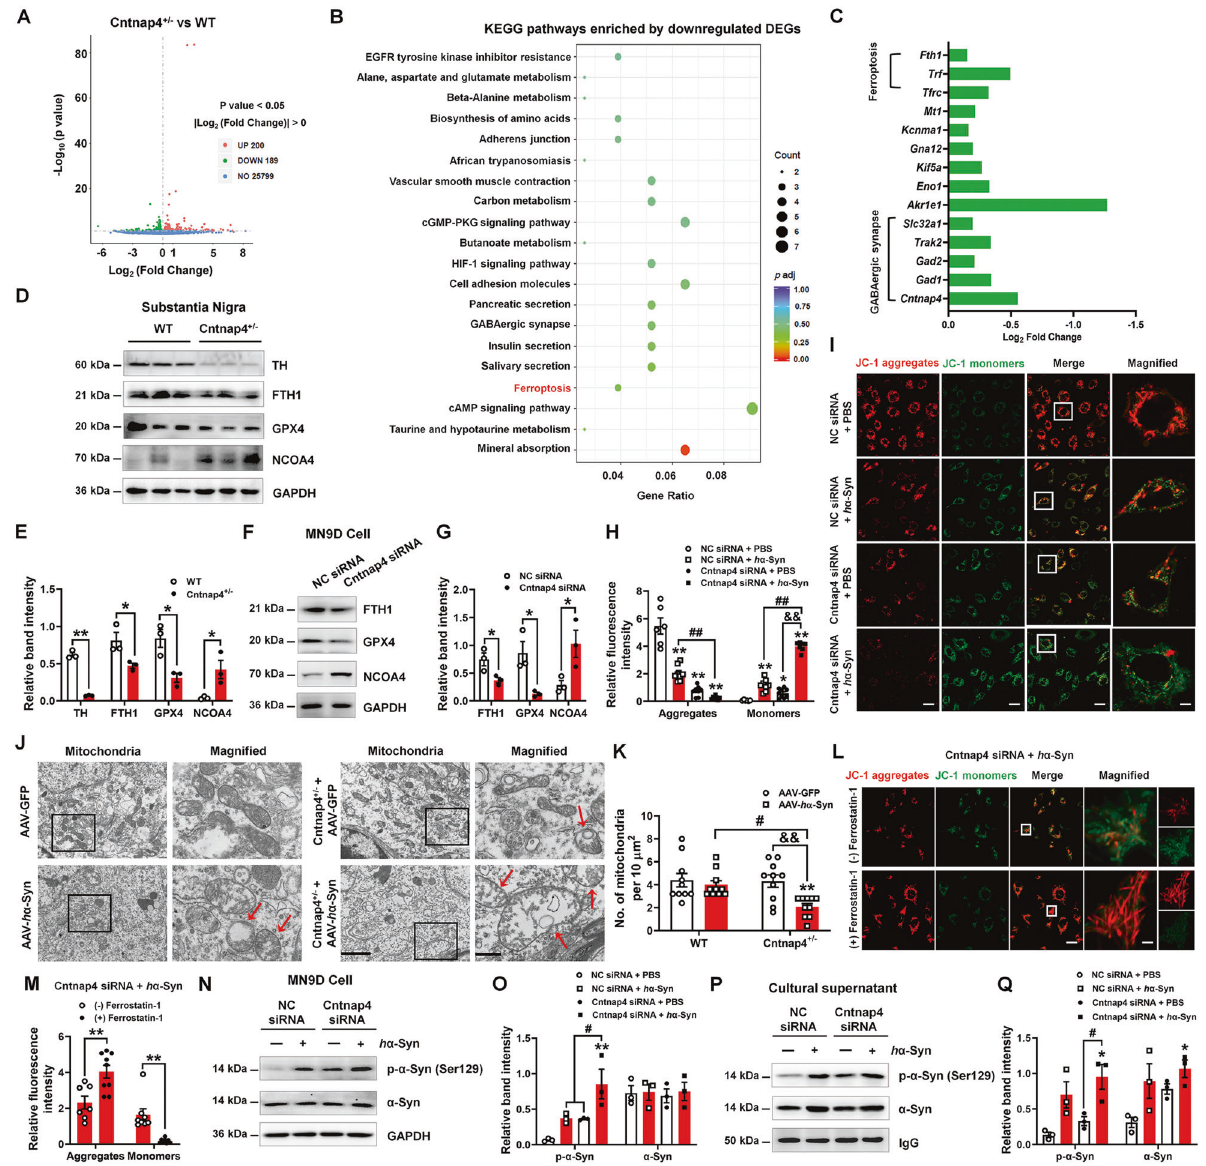
Fig. 2 Cntnap4 partial de fi ciency damages mitochondrial function and induces α -synuclein release via ferroptosis. A DEGs between Cntnap4 + / − and WT mice are shown in a volcano plot. B KEGG pathways enriched by downregulated DEGs between Cntnap4 + / − and WT mice. Note that ferroptosis is highlight in red. C Representative downregulated DEGs enriched in ferroptosis and GABAergic synapse. D , E The protein expression levels of TH, FTH1, GPX4, and NCOA4 in the SN were determined by western blotting; n = 3 per group. F , G The protein expression levels of FTH1, GPX4, and NCOA4 in MN9D cells treated with NC siRNA and Cntnap4 siRNA were determined by western blotting; n = 3 per group. H , I Immuno fl uorescence staining and quanti fi cation of JC-1 aggregates and monomers in MN9D cells treated with NC siRNA + PBS, NC siRNA + h α -Syn, Cntnap4 siRNA + PBS, and Cntnap4 siRNA + h α -Syn. Scale bars: 20 μ m. Magni fi ed fi gures are shown in the right column of panel I . Scale bars: 4 μ m; n = 6 – 9. J , K Ultrastructural analysis of mitochondria in the SNpc of WT and Cntnap4 + / − mice injected with either AAV- GFP or AAV- h α -Syn. Scale bars, 2 μ m, and 500 nm for magni fi ed images. Red arrows show mitochondrial swelling and mitochondrial cristae disappearance. n = 10 per group. L , M Immuno fl uorescence staining and quanti fi cation of JC-1 aggregates and monomers in MN9D cells treated with Cntnap4 siRNA + h α -Syn plus ferrostatin-1. Scale bars: 20 μ m. Magni fi ed fi gures are shown in the right column of panel L . Scale bars: 2 μ m; n = 7 – 9. N , O The protein expression levels of phosphorylated and mouse α -synuclein in MN9D cells treated with NC siRNA + PBS, NC siRNA + h α - Syn, Cntnap4 siRNA + PBS, and Cntnap4 siRNA + h α -Syn; n = 3 per group. P , Q Supernatant levels of phosphorylated and mouse α -synuclein from MN9D cells treated with NC siRNA + PBS, NC siRNA + h α -Syn, Cntnap4 siRNA + PBS, and Cntnap4 siRNA + h α -Syn; n = 3 per group. Results are expressed as the mean ± SEM. ** p < 0.01, * p < 0.05 vs . WT or NC siRNA; ## p < 0.01, # p < 0.05 vs. AAV- h α -Syn or NC siRNA + h α -Syn; && p < 0.01 vs. Cntnap4 + / − + AAV- h α -Syn or Cntna p 4 siRNA + PBS. Statistical signi fi cance was determined using Student ’ s t -test ( E , G , M ), one-way ANOVA + Tukey ’ s multiple comparisons test ( H , O , Q ), and two-way ANOVA + Bonferroni ’ s multiple comparisons test ( K ).